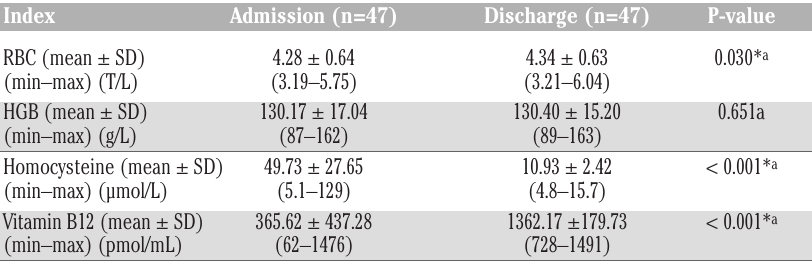
Table 2. Comparison of test index values between admission and